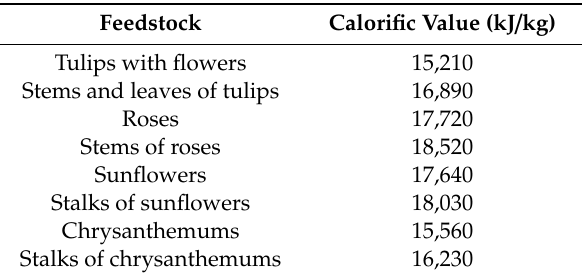
Table 1. Calorific value of floricultural waste. Feedstock Calorific Value (kJ / kg) Tulips with flowers 15,210 Stems and leaves of tulips 16,890 Roses 17,720 Stems of roses 18,520 Sunflowers 17,640 Stalks of sunflowers 18,030 Chrysanthemums 15,560 Stalks of chrysanthemums 16,230